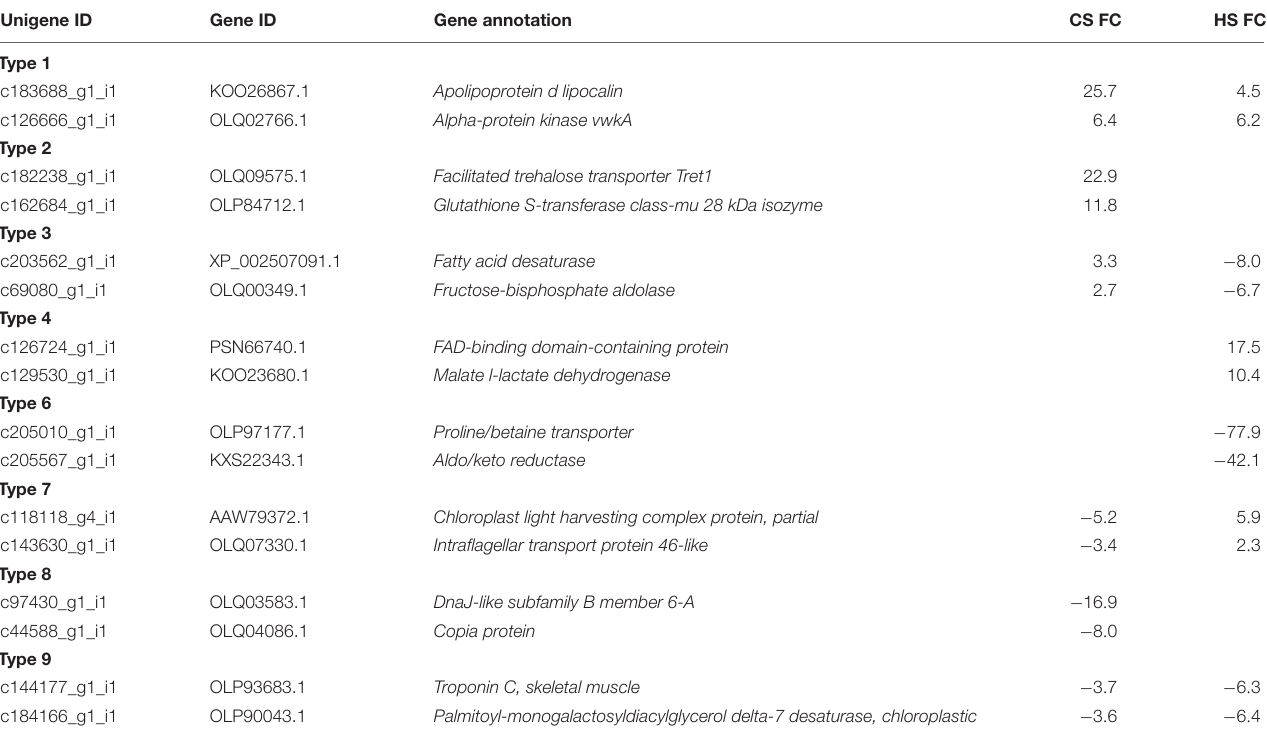
TABLE 4 | Two differentially expressed unigenes of Biecheleriopsis adriatica belonged to each expression type. Unigene